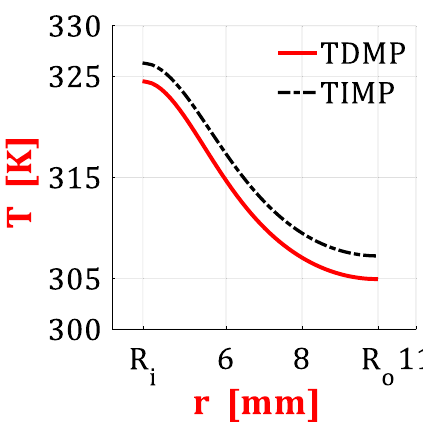
Fig. 11 Temperature–time history of the tube boundaries for 10 cycles